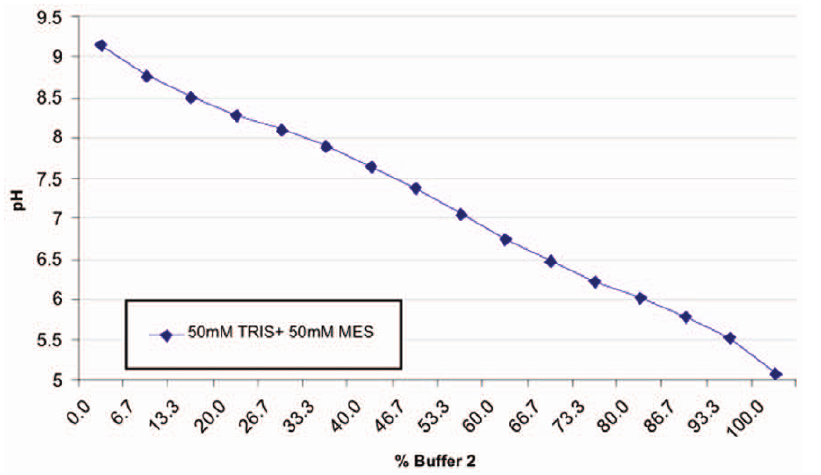
Figure 9. The calibration curve used for converting between buffer-fractions and pH values. The measured pH values of 16 different mixtures are shown as dots. Notice the nearly linear dependence between buffer-composition and pH in the range between pH 8.5 and pH 5.5.